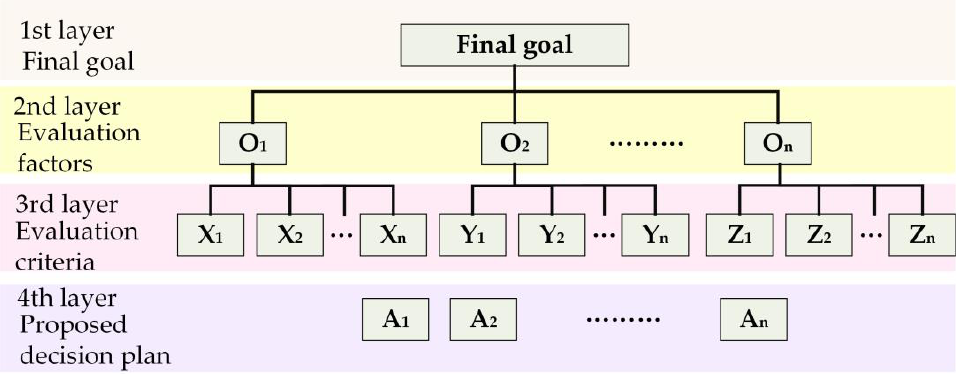
Figure 4. Structural diagram of the AHP.